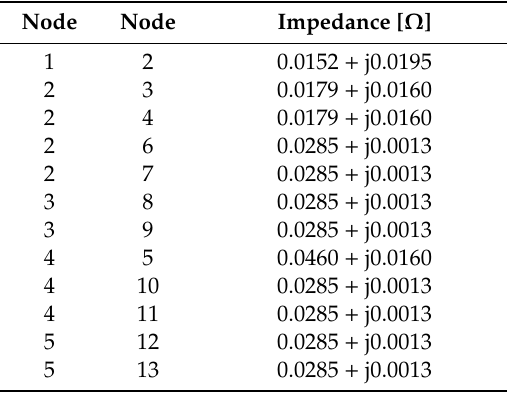
Table 3. Case of interconnections of PCS.